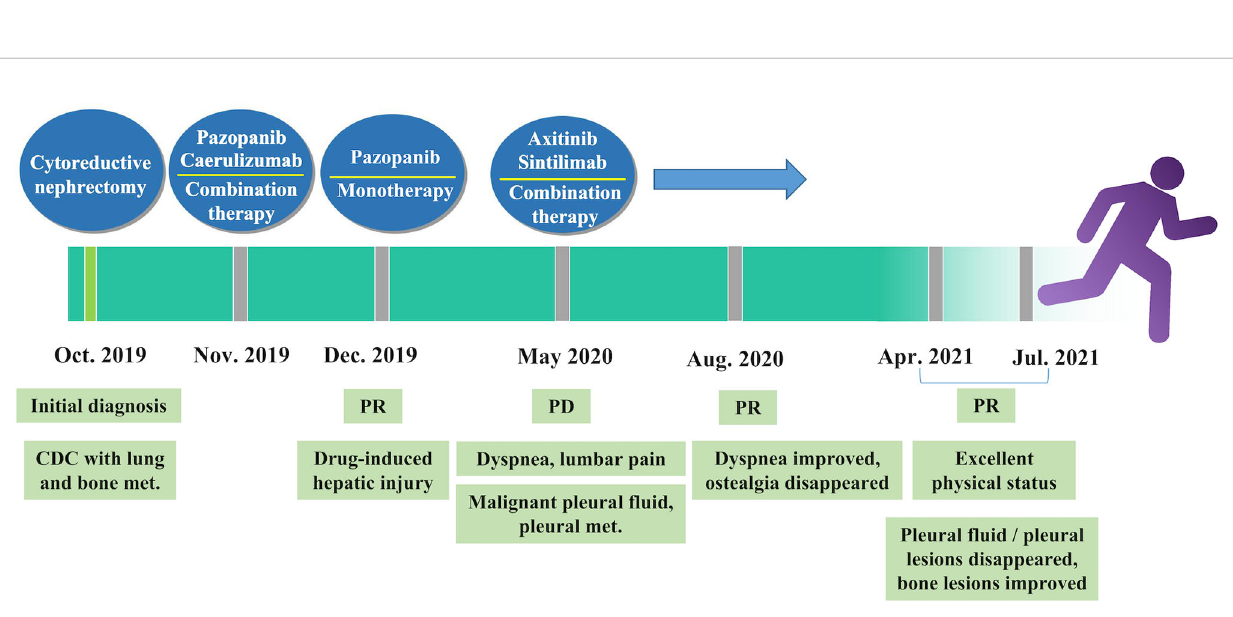
FIGURE 3 | Chest and spinal CT imaging manifestations after treatment. (A) First diagnosis. (B) After one cycle of pazopanib and camrelizumab. (C) Discontinuation of camrelizumab and monotherapy involving pazopanib for 5 months. (D) Three months after the combination treatment of axitinib and sintilimab. (E) Fourteen months after the combination treatment of axitinib and sintilimab. CT, computed